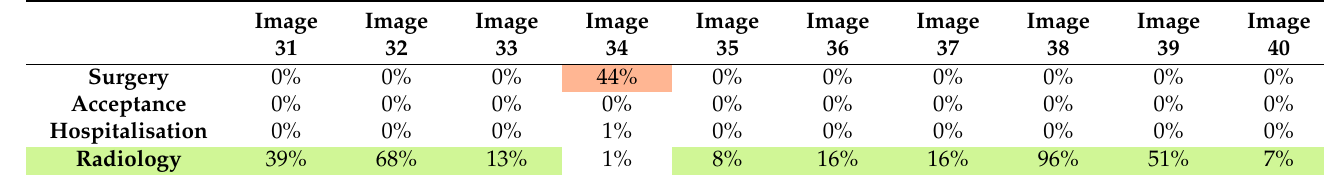
Table 9. Results obtained with the first version of the customised model for the “radiology” IU. Each column refers to one of the test images (31 to 40) and each row shows the labels that were returned by the model. The row–column intersection shows the success rate in recognising the concept stated in the row for the image in that column.